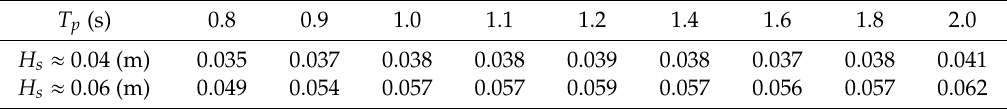
Table 1. Experimental values of H s for JONSWAP spectra with γ = 3.3.